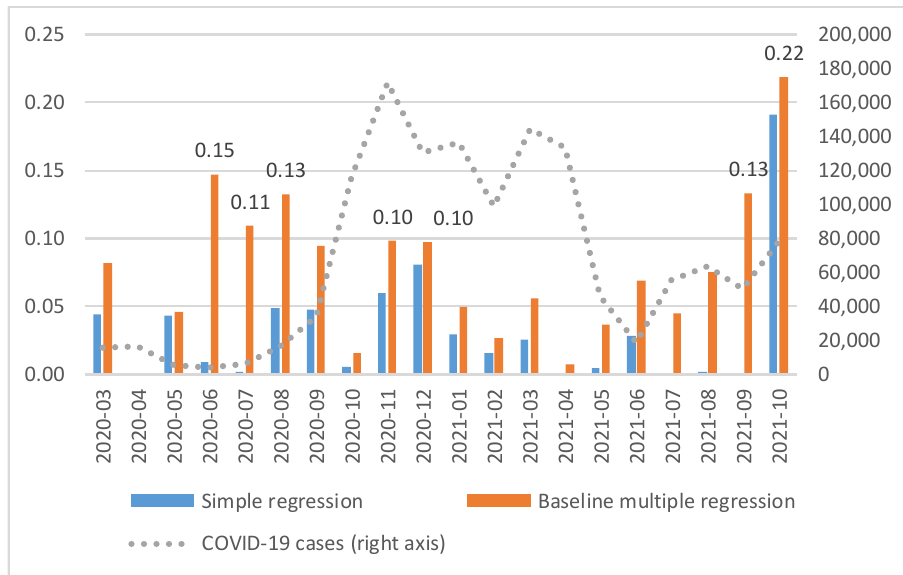
Figure 1. Coefficients of determination in simple regression and in baseline multiple regression and COVID-19 cases in 20 months for the 20 countries under review. Source: Authors’ calculation, using data specified in the Data Availability Statement.